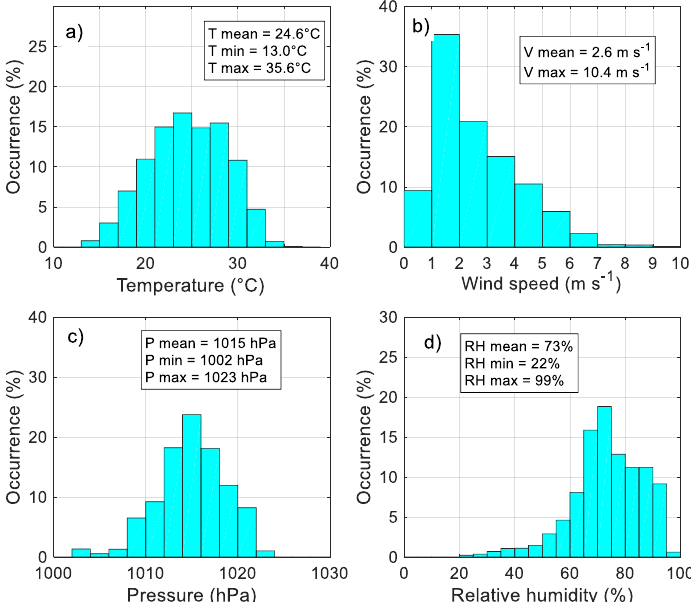
Figure 4. Histograms of ( a ) temperature, ( b ) wind speed, ( c ) pressure, and ( d ) relative humidity for the summer seasons of 2015–2016. Hourly averages were used to calculate the histograms.